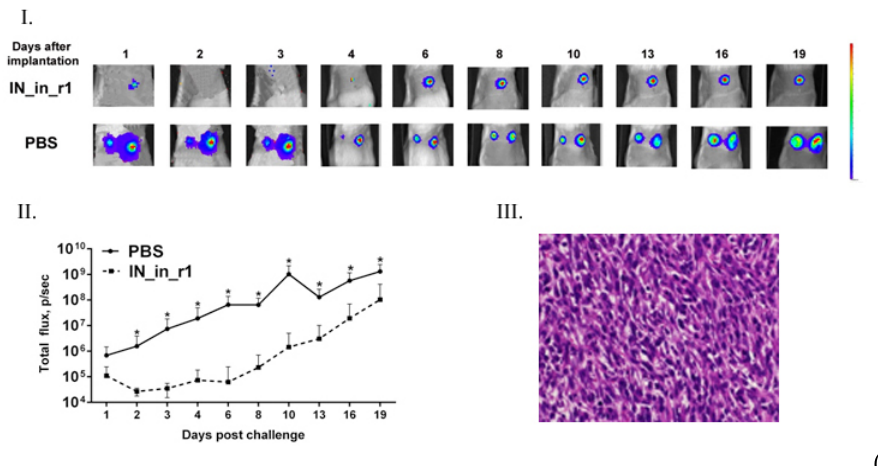
Figure 14a–c). The phenomenon was specifically pronounced for mice DNA-immunized with IN_in_r1 (Figure 14a, panels I, II). Mice immunized with empty vector demonstrated elevated rate of tumor growth compared to IN DNA-immunized mice and mice receiving PBS (Figure 14c; panels I, II; p -values are indicated in the figure caption). IN_in_r1-immunized mice were also statistically significant different, and IN_in_r2 tended to differ from the vector-immunized controls in the number of “successful” tumor cell implantations (Figure 14d). While all vector- and PBS-immunized mice